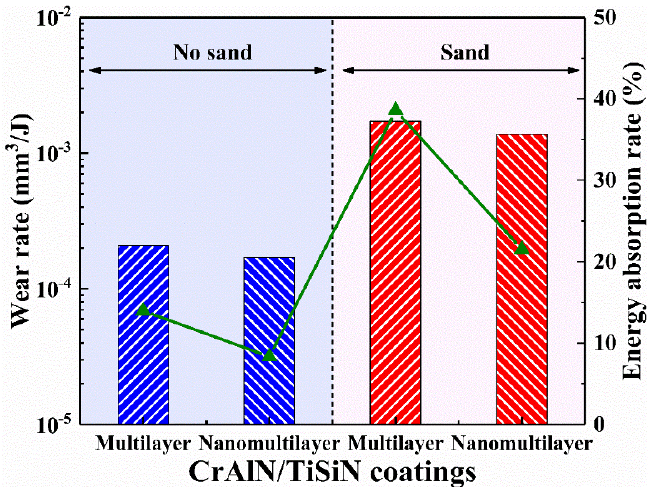
Figure 11. Wear rate and energy absorption rate of two coatings with and without sand.